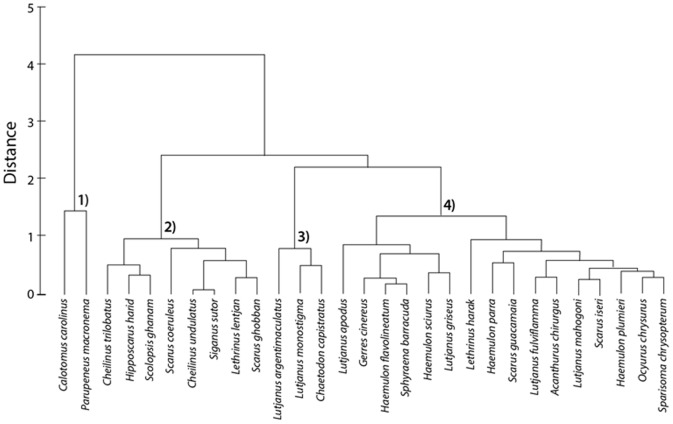
Cluster analysis plot based on Euclidean distances using Hedges' d values for all three habitat comparisons per fish species.Species from the Caribbean and Indo-Pacific are combined. Species for which one or more habitat comparisons were absent were omitted as no distance measure could be calculated.